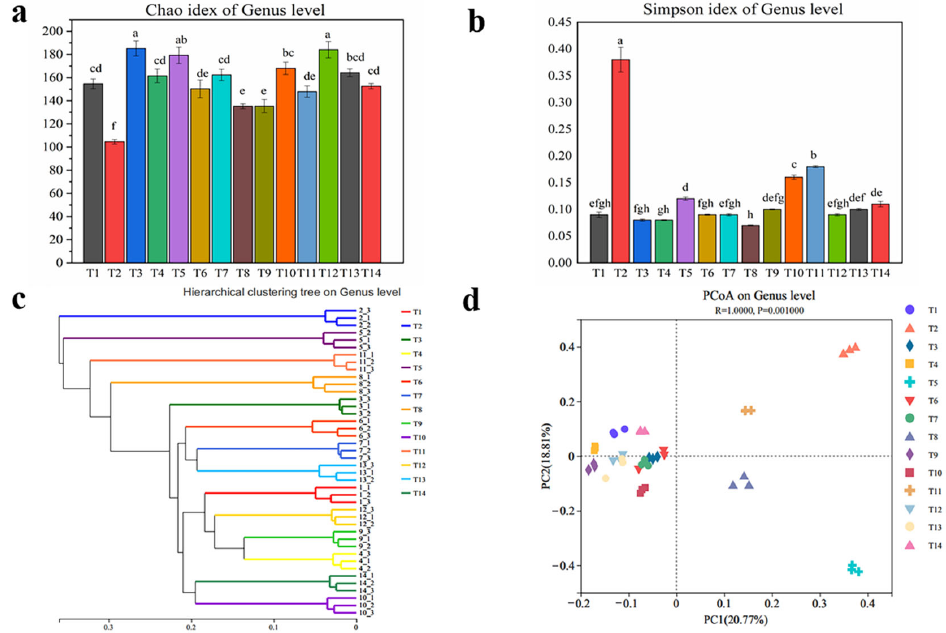
Figure 4. Alpha diversity analysis, cluster analysis, and PCoA analysis of fungal genera in soil samples from different aged apple orchards. ( a ) Chao index of fungi; ( b ) Simpson index of fungi; ( c ) Hierarchical cluster analysis of fungi; ( d ) PCoA analysis of fungi. A single ‐ factor ANOVA was used to test the differences in alpha and beta diversity of soil samples from different aged apple orchards, and the y ‐ axis shows the average value of each index. Values followed by different letters indicate significant difference among treatments ( p < 0.05) T1: Gao Bao Village; T2: Lu Bai Village; T3: Bei An Shan Village; T4: Lunar Eclipse Village; T5: Bei Gu Village; T6: Yang Wu Village; T7: Bed Guang Rong Village; T8: Bai Jia Zui Village; T9: Northwest Ding Village; T10: Shang Cao Di Village; T11: Shang Huang Zhang Village; T12: Gu Xian Village; T13: Jing Yao Ke Village; T14: A Si Village.